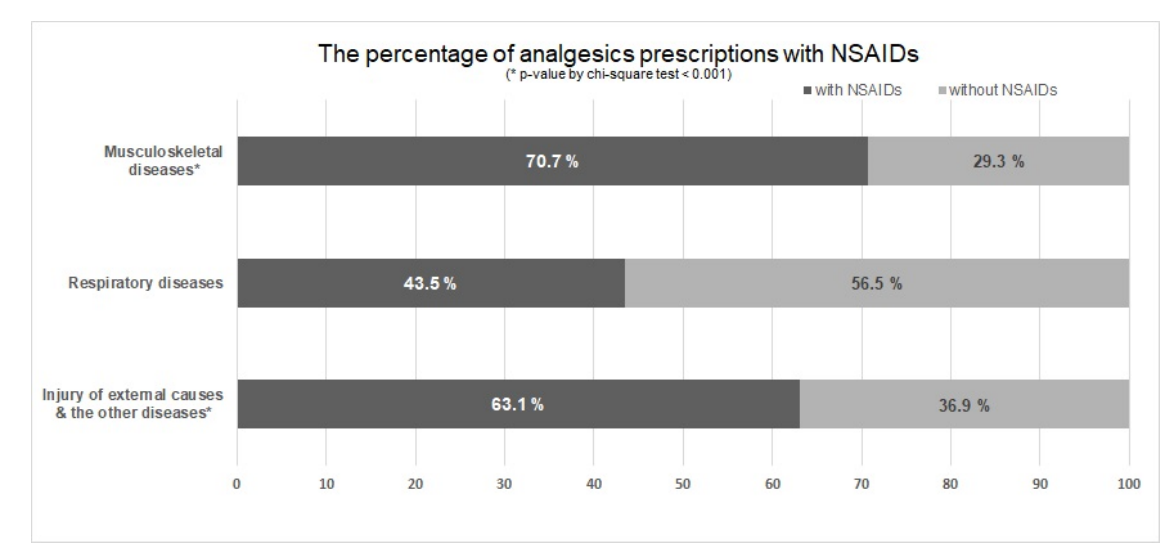
Figure 4. The proportions of non-steroidal anti-inflammatory drug (NSAID) prescriptions in anal- gesics for each indication among patients with a history of myocardial infarction.